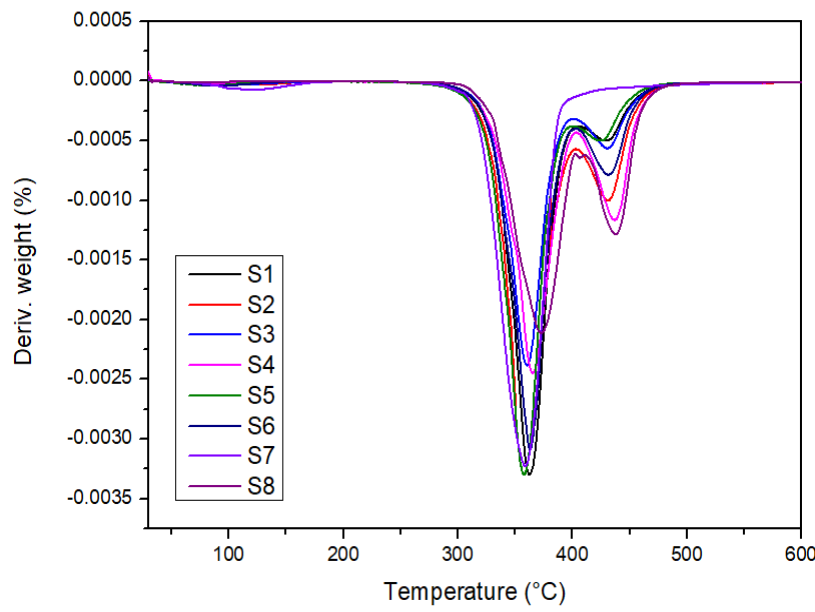
Figure 3. DTG thermogram of laminated composites .